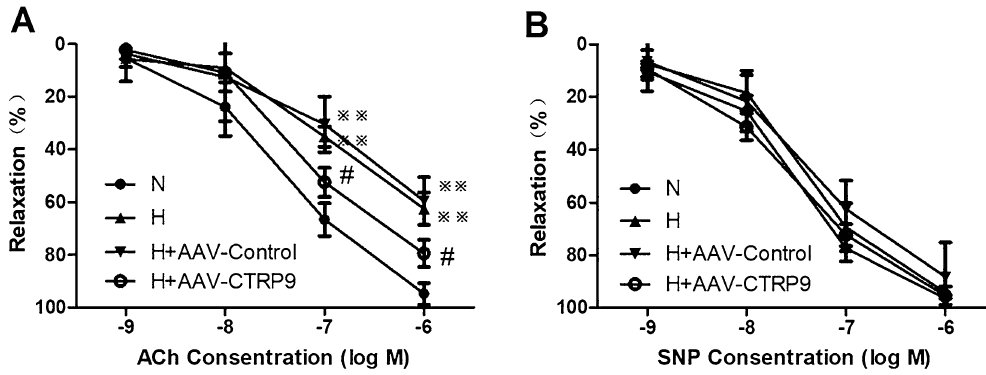
Figure 3. CTRP9 overexpression improved endothelial function in pulmonary arteries from HPH rats. ( A ) Dose–response curves for ACh-induced relaxation were obtained from pulmonary arteries of different groups (n = 6). Data are expressed as the percentage of the contraction to phenylephrine (PE). ( B ) Dose–response curves for SNP-induced relaxation were obtained from pulmonary arteries of different groups (n = 6). Data are expressed as the percentage of the contraction to PE. Data are the mean ± SEM. P < 0.01 vs. group N; # P < 0.05 vs. group H + AAV-Control. N normoxia for 4 weeks, H4 hypoxia for 4 weeks, H + AAV-Control transfection of ※※ AAV-Control vectors maintained at hypoxia for 4 weeks, H + AAV-CTRP9 transfection of AAV-CTRP9 vectors maintained at hypoxia for 4